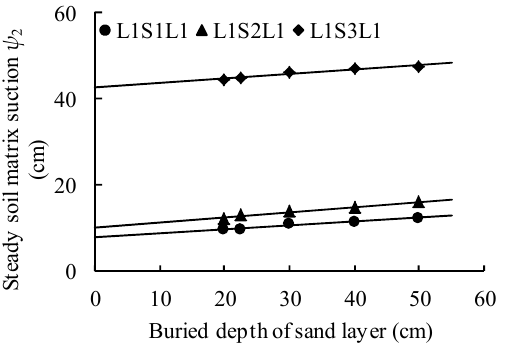
Figure 7. The distribution of soil water content along the soil profile when the buried depth of sand is 50 cm and the infiltration time is 300 min. Table 4. Parameters of the new, modified Green ‐ Ampt model for the laboratory infiltration experiment. Cases